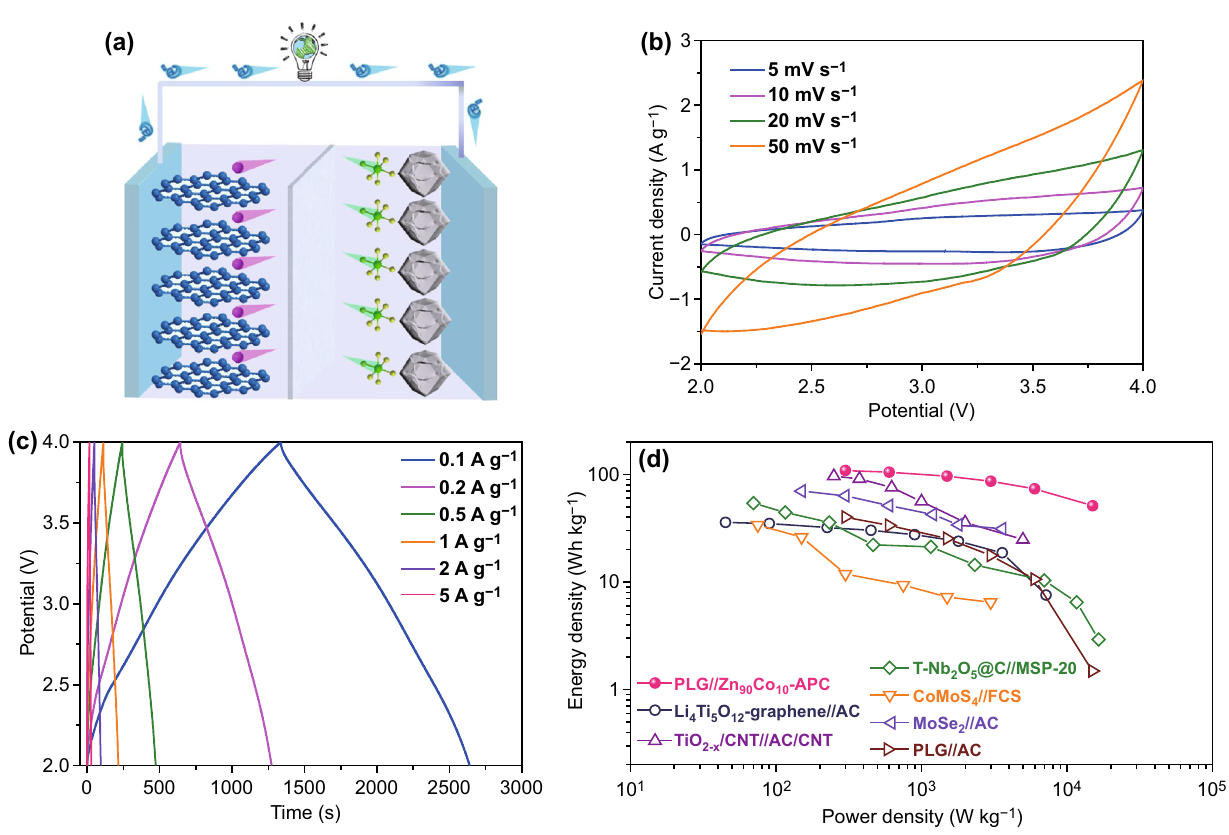
Fig. 9 a Schematic illustration of the charge‑storage mechanisms for the LICs. b CV curves and c GCD profiles of PLG//Zn 90 Co 10 ‑APC LIC. d Ragone plots of this work compared with other reported